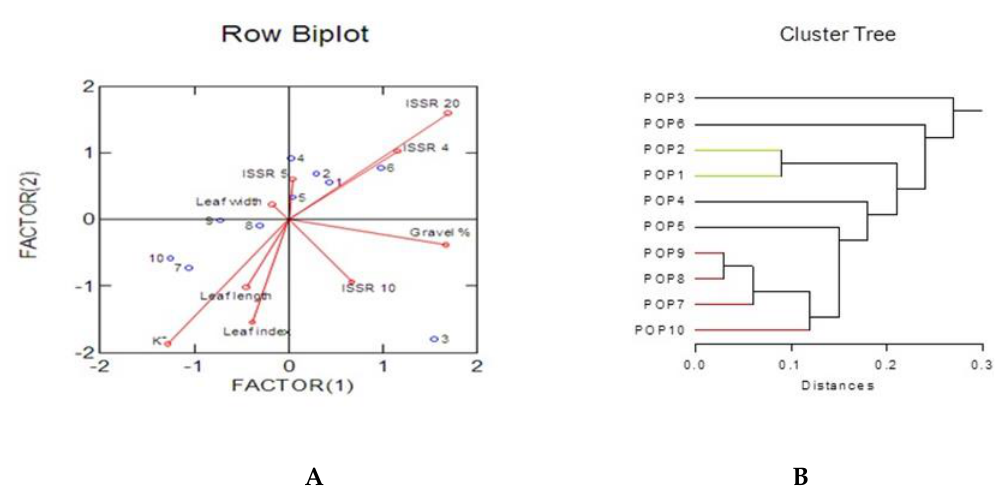
Figure 7. ( A ) Biplot mapping among ten populations of A. javanica based on morphological variations,